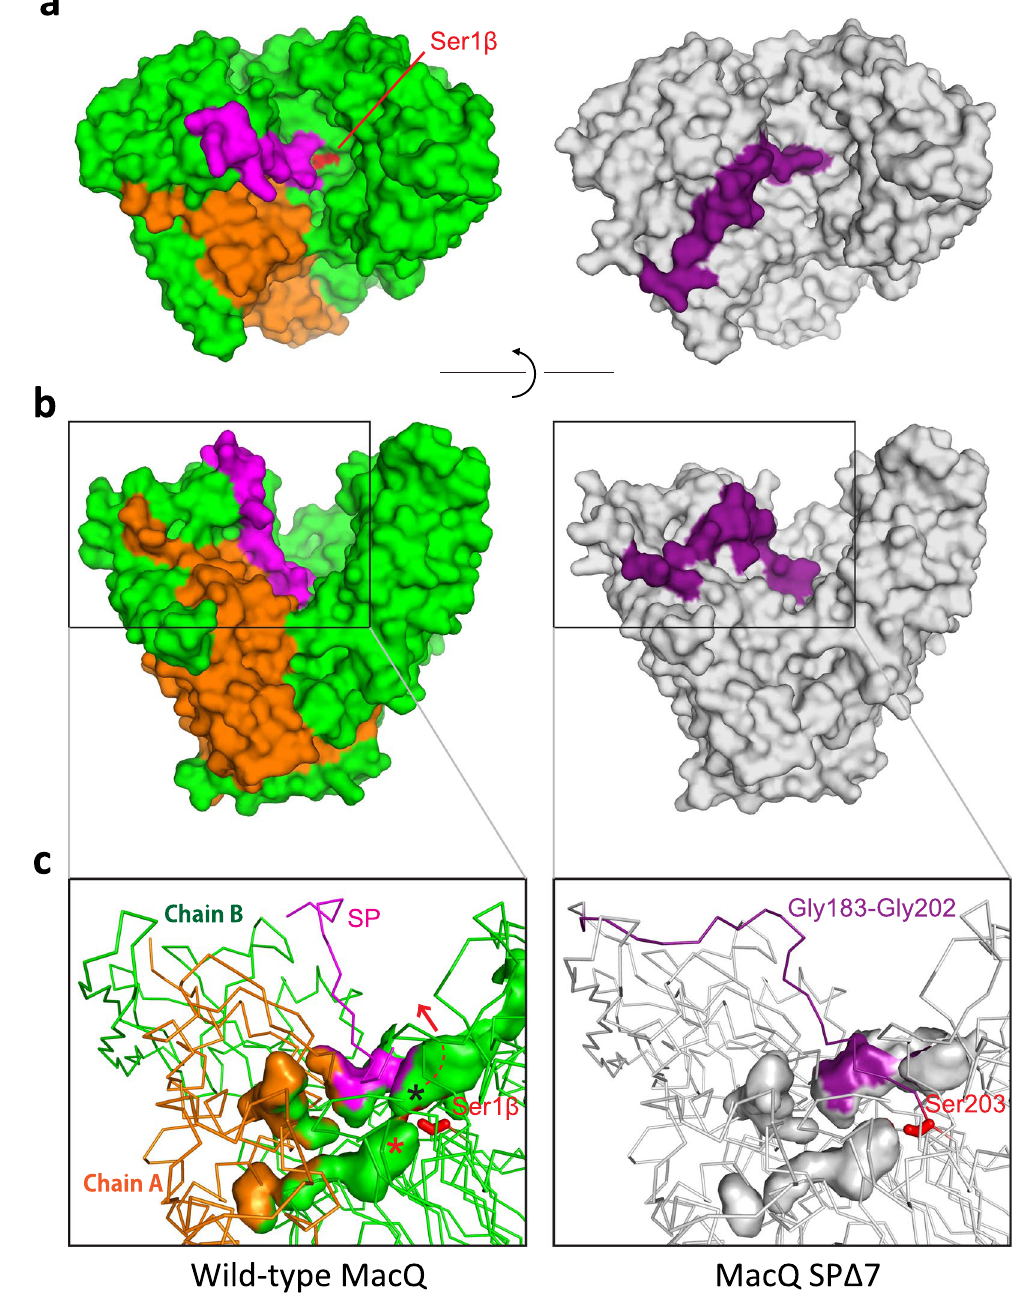
Figure 6. Comparison of molecular surface and active site cavities of wild-type MacQ and SP Δ 7 mutant. ( a ) Top view and ( b ) side view molecular surface representation of heterodimeric wild-type MacQ and monomeric (uncleaved) SP Δ 7. The colour scheme corresponds to Fig. 5d. The Ser1 β of wild-type MacQ is located at the depth of the active-site cleft and is accessible from the solvent, while the corresponding Ser203 in SP Δ 7 is buried inside due to the presence of uncleaved chain. ( c ) Active site cavities of the heterodimeric wild-type MacQ and monomeric (uncleaved) SP Δ 7. The Ser1 β /203 is represented as a stick model and coloured in red. C 10 /PAA binding pocket and the putative HSL/6-APA binding position are indicated by asterisk in red and black, respectively. The red arrow represents the putative releasing route of the HSL/6-APA from the pocket in the vicinity of Ser1 β . The corresponding pocket is not formed in the structure of SP Δ 7 due to the presence of uncleaved polypeptide